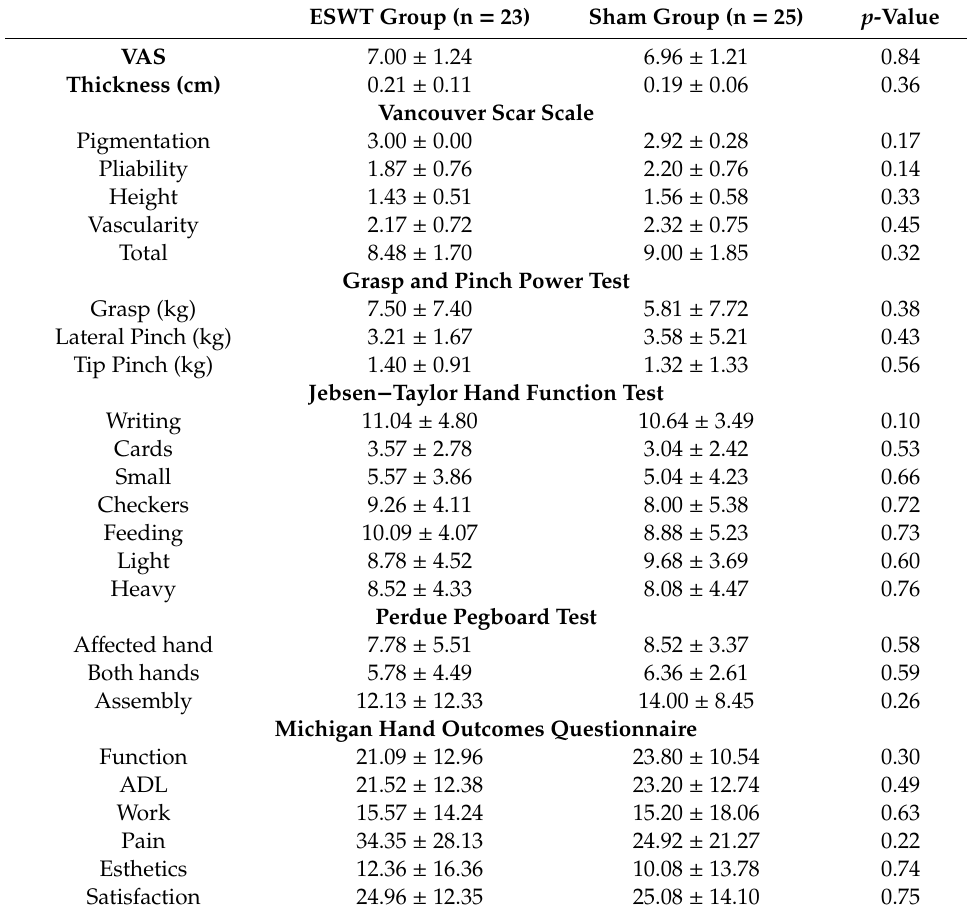
Table 2. Outcome measures at baseline.